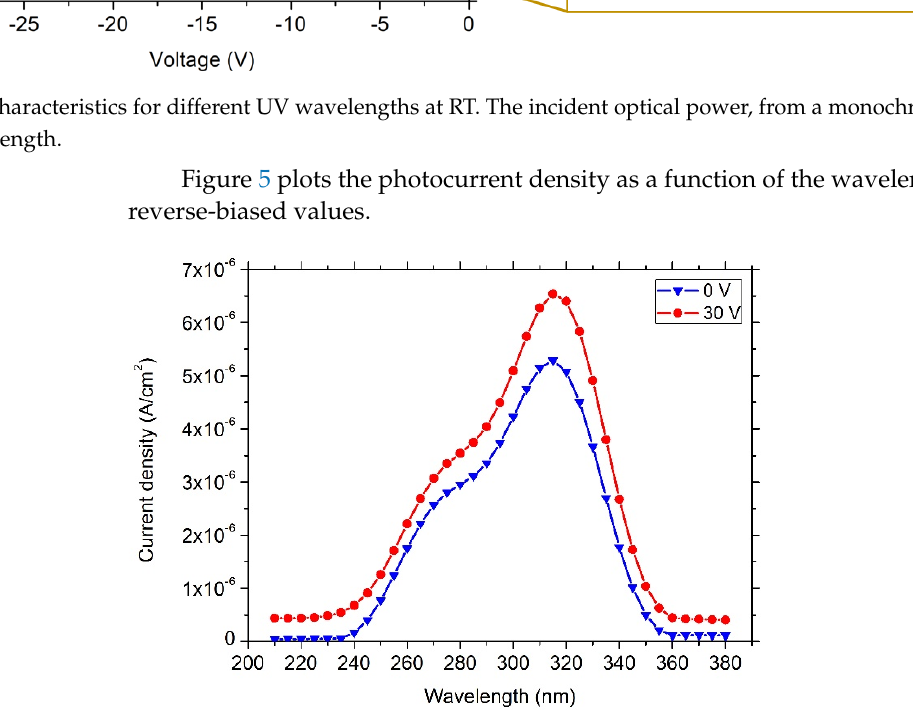
Figure 5. Photocurrent density as a function of the wavelength values at 0 and 30 V reverse bias.